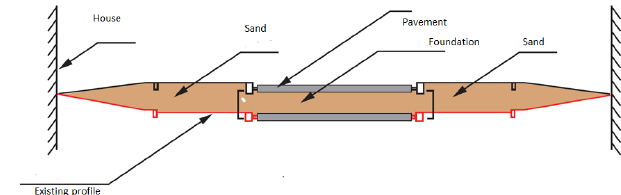
Figure 1. Traditional solution.